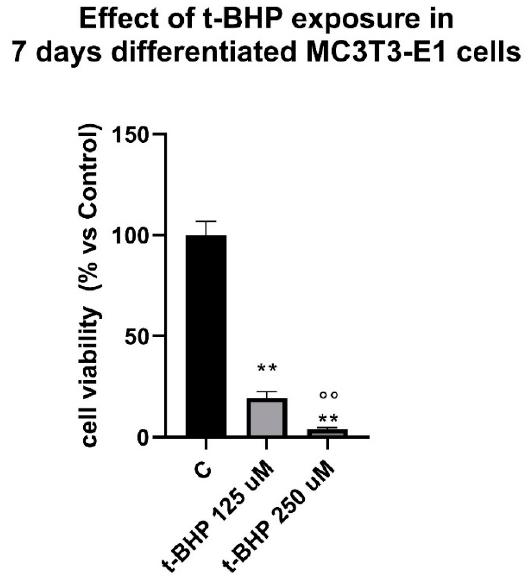
Figure A1. The figure shows the effects of t-BHP on 7-day-MC3T3E1-differentiated cells. We used 250 µ M or 125 µ M for 3 h of t-BHP to induce oxidative stress. The figure shows that 7-day-MC3T3E1- differentiated cells are more sensitive to t-BHP 250 µ M than 125 µ M. ** p < 0.001 vs. control. ◦◦ p < 0.05; vs. t-BHP 125 µ M.